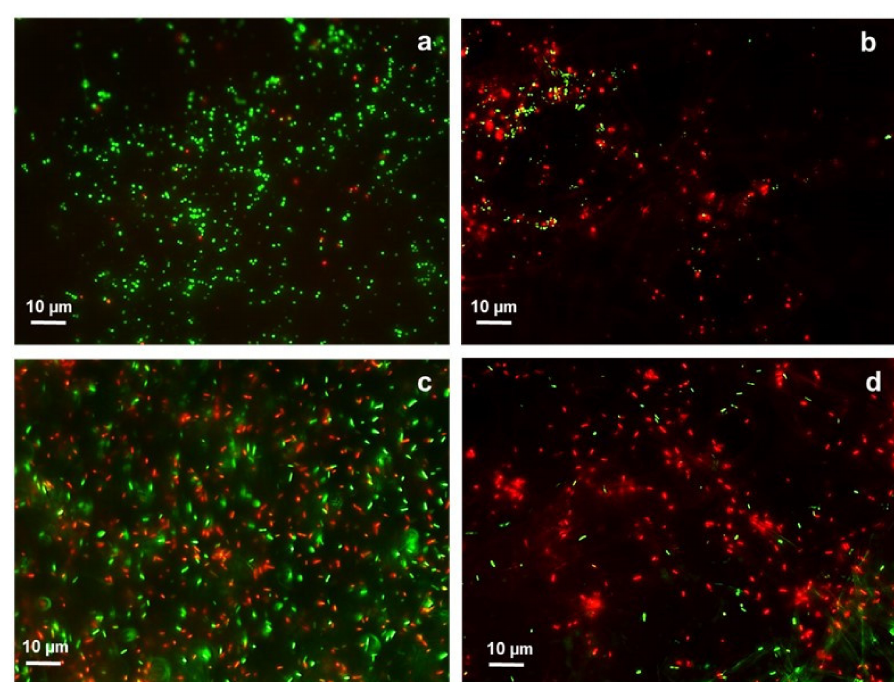
Figure 6. Fluorescence microscopy images of S. aureus on the surface of inorganic SiO 2 fibres ( a ) and on the surface of hybrid DACHsilane fibres ( b ). P. aeruginosa present on the surface of inorganic SiO 2 fibres ( c ) and on the surface of hybrid DACHsilane fibres ( d ). Green dots indicate live cells, while red dots dead cells.